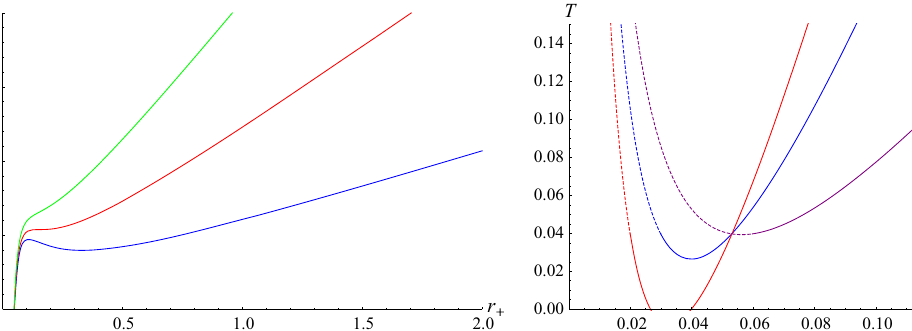
purple, blue and red curves correspond to P = 1, 2, 3, respectively, at m = c = − c 1 = − c 2 = 1 and k = 1 π . The dashed parts correspond to the regions that there has no the black hole solution